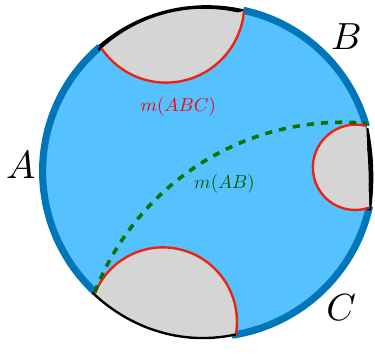
Figure 9 . The reduction to r ( ABC ). Imposing a second constraint reduces the manifold further to r ( AB